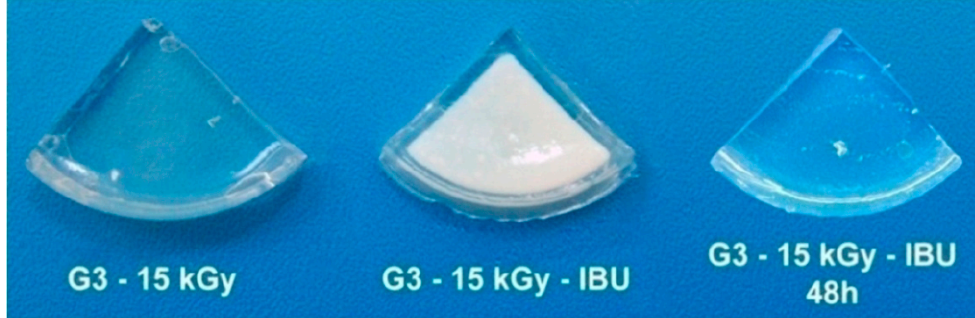
Figure 11. Picture of hydrogels obtained upon irradiation at 15 kGy, after encapsulation with ibuprofen (IBU) and respectively after complete drug release.